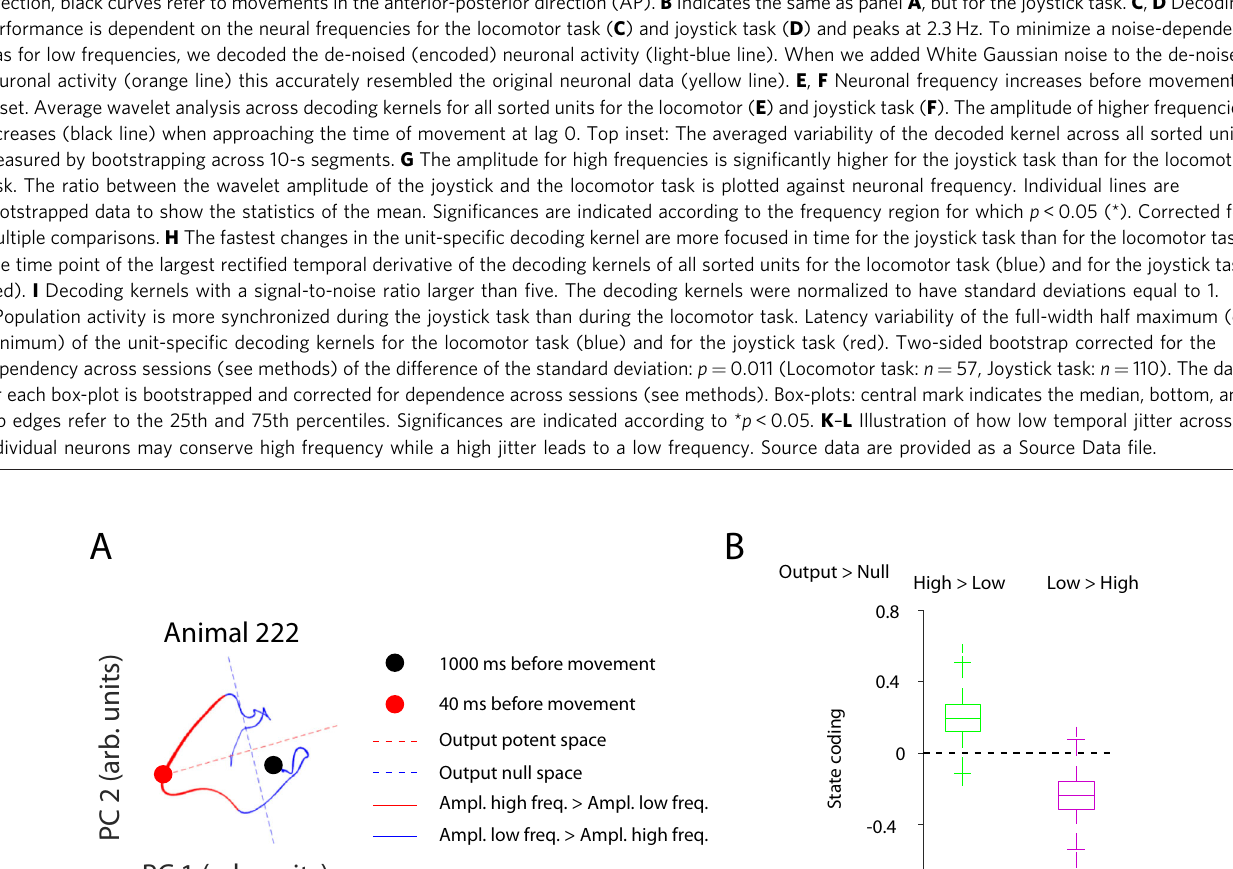
Fig. 6 Ratio of high- to low-frequency changes of neuronal data predicts state spaces. A Example sessions of dimension-reduced population coding for animal 222. The trajectory is divided into paths for which the high frequency (>1.1 Hz) had a larger amplitude than the low frequency (<1.1 Hz) (red), and into segments for which the high frequency had a smaller amplitude than the low frequency (blue). Output-null (blue) and output-potent spaces (red) are indicated by dashed lines. The thickness of the trajectory indicates the averaged paw velocity. Thicker lines refer to higher velocities. B Quanti fi cation of the results in panel A for all animals. The average state coding was calculated for preferentially high- and low-frequency coding. A negative- or positive-state coding value refers to a dominant null space or output-potent space, respectively. The frequency coding is de fi ned by either a dominance of high or low frequencies of neuronal changes. Dominant high-frequency changes are associated with the output-potent space, whereas dominant low-frequency changes were correlated with the null space. Two-sided paired t -test. Data sample dependence correction for the temporal smoothing of 10 samples. High frequency: p = 0.033 ( n = 9439 low-frequency time points), Low frequency: p = 0.04 ( n = 5837 high-frequency time points). The data for each box-plot is bootstrapped and corrected for dependence across sessions (see methods). Box-plots: central mark indicates the median, bottom, and top edges refer to the 25th and 75th percentiles. Source data are provided as a Source Data fi